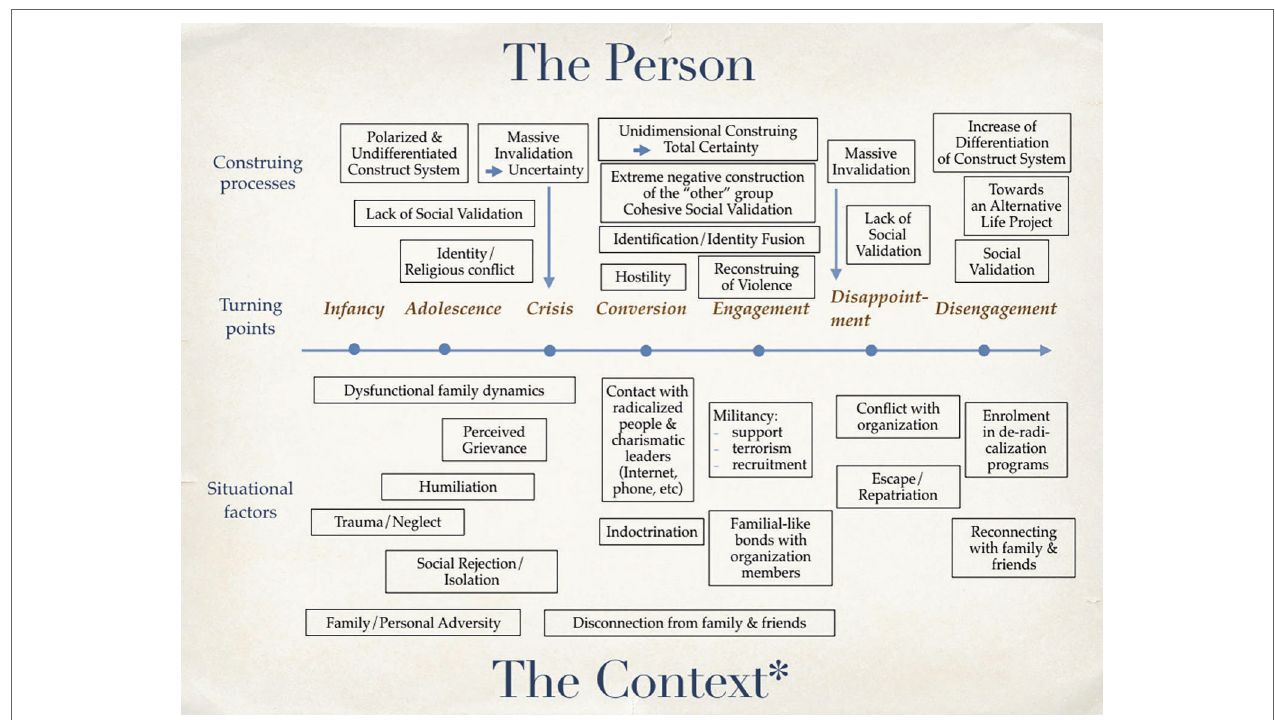
FIGURE 1 | A personal construct heuristic model for the process of radicalization and deradicalization. Vertical arrows indicate “Transformative Trigger”. *Broader context includes social and political national/international conflicts, economic inequalities, religious fundamentalist confronted discourses (in worship places or web pages), social marginalization, and